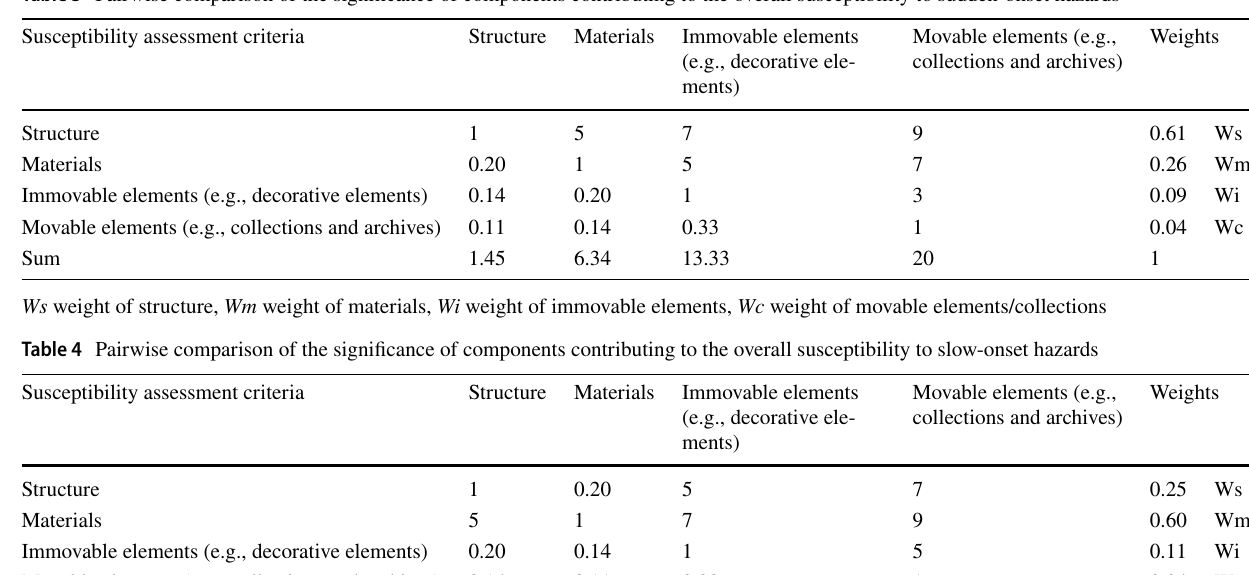
Table 3 Pairwise comparison of the significance of components contributing to the overall susceptibility to sudden-onset hazards